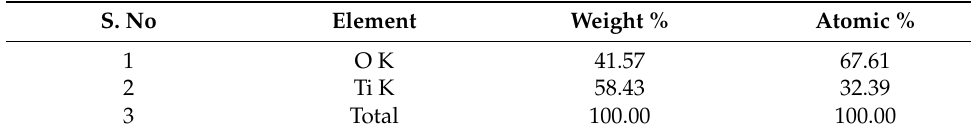
Figure 11. EDX analysis of TiO 2 . Table 4. TiO 2 nano-catalyst’s chemical